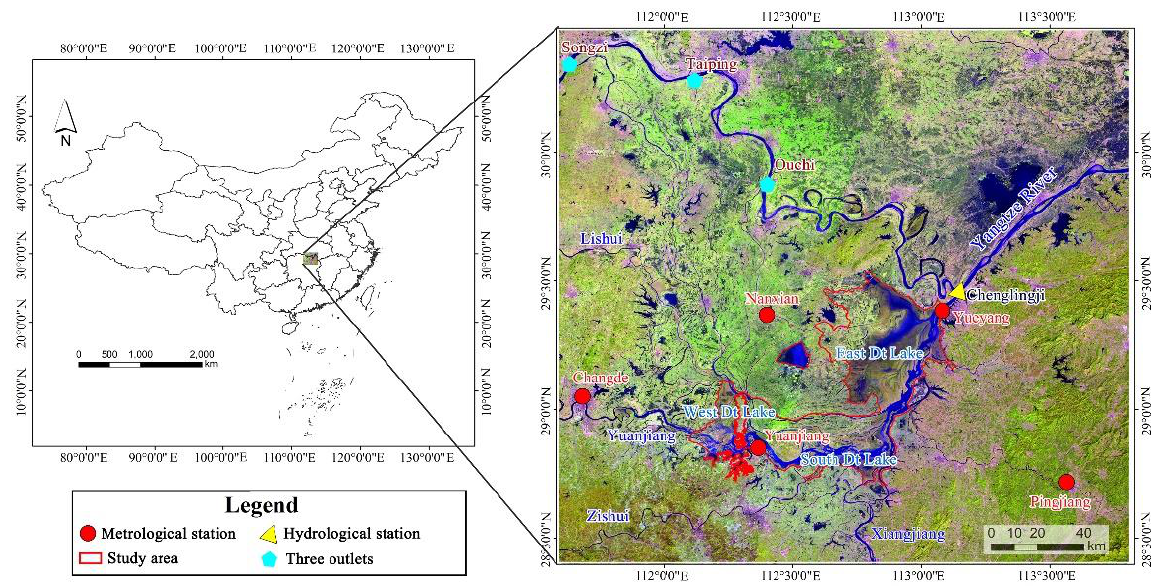
Figure 1. Map of the study